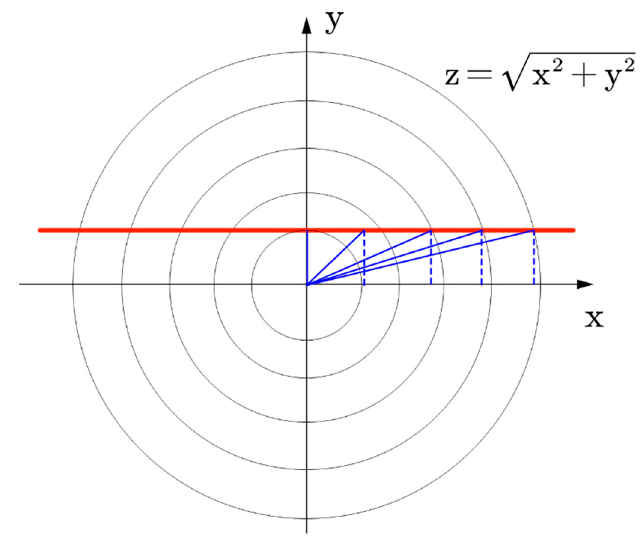
Figure 20. Circular system equation.